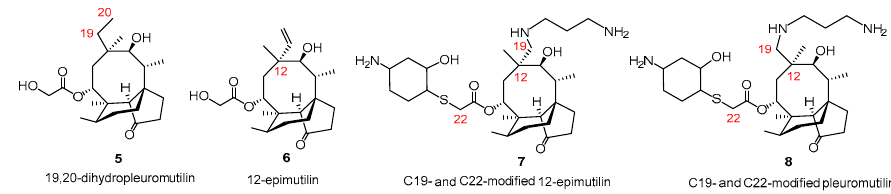
Figure 2. Structural modifications of pleuromutilin and C12- epi -mutilin at position C19-C20.